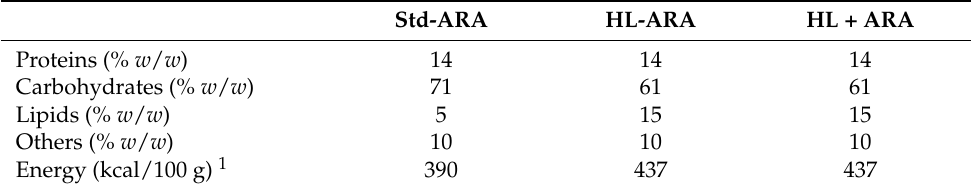
Table 1. Nutritional profile of experimental diets.